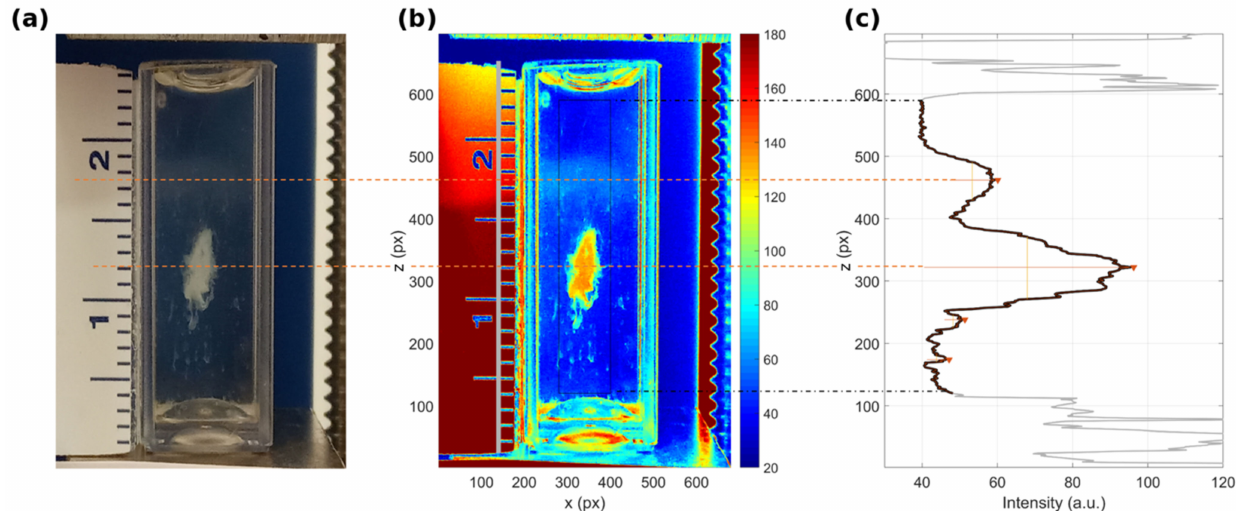
Figure 2. Representative outcome of the image processing. ( a ) Optical image of a MagLev pattern. ( b ) Corresponding pseudo-color image. ( c ) Evaluation of the intensity profile and determination of locations, amplitude, and width of the detected peaks. Dashed lines indicate the vertical limits of the region of interest (black) and the computed location of the detected peaks